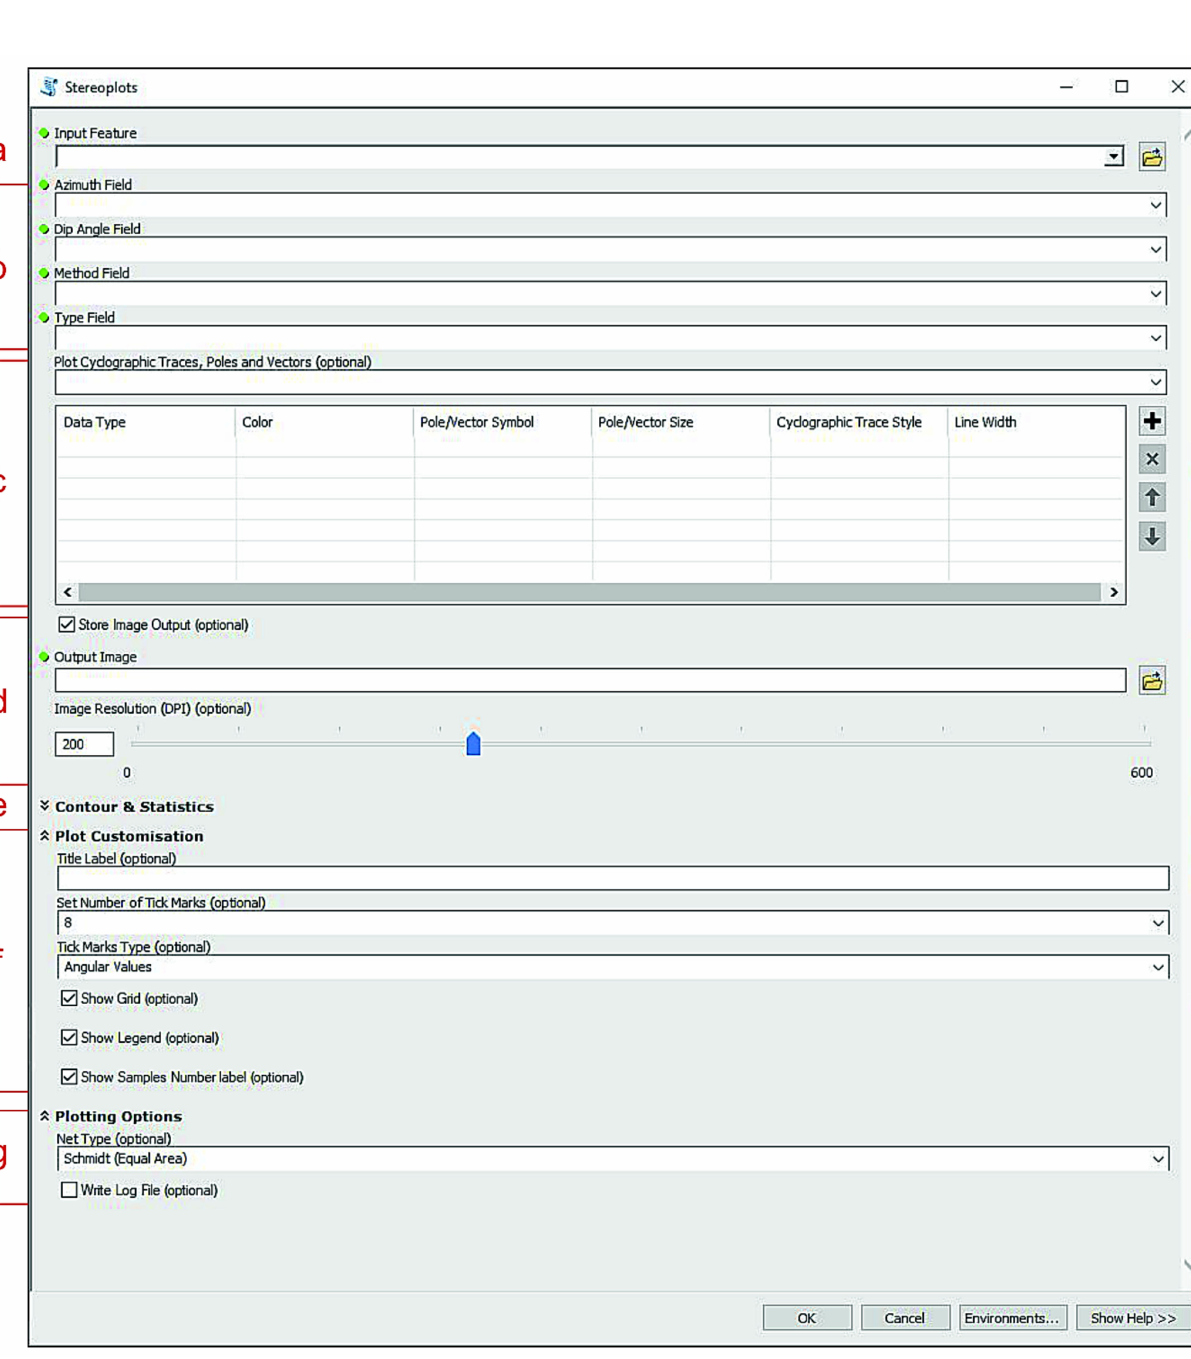
Figure 2. ‘Stereoplots’ tool layout. Green dots indicate required parameters. ( a ) Oriented dataset input; requires a shapefile (point, line, and polygon features types are supported). ( b ) Azimuth, Dip Angle, Method, and Type fields inputs, selectable through the drop-down menus. ( c ) Plotting data Value Table; for each added feature type the user can specify the plotting colour, pole, or vector symbol and size, cyclographic trace style, and width. ( d ) Output image settings; the stereoplot can be saved as a temporary file by unchecking the ‘Store Image Output’ option, otherwise an output file path can be selected. ( e ) ‘Contour & Statistics’ submenu; see Figure 3 for details. ( f ) Plot customisation submenu; enables the look of stereoplot to be customised. ( g ) Plotting options submenu; the stereonet type can be chosen (equal-area or equal-angle) and the ‘Write Log File’ option can be checked to prompt the tool to compile a text file storing statistical information concerning the plotted